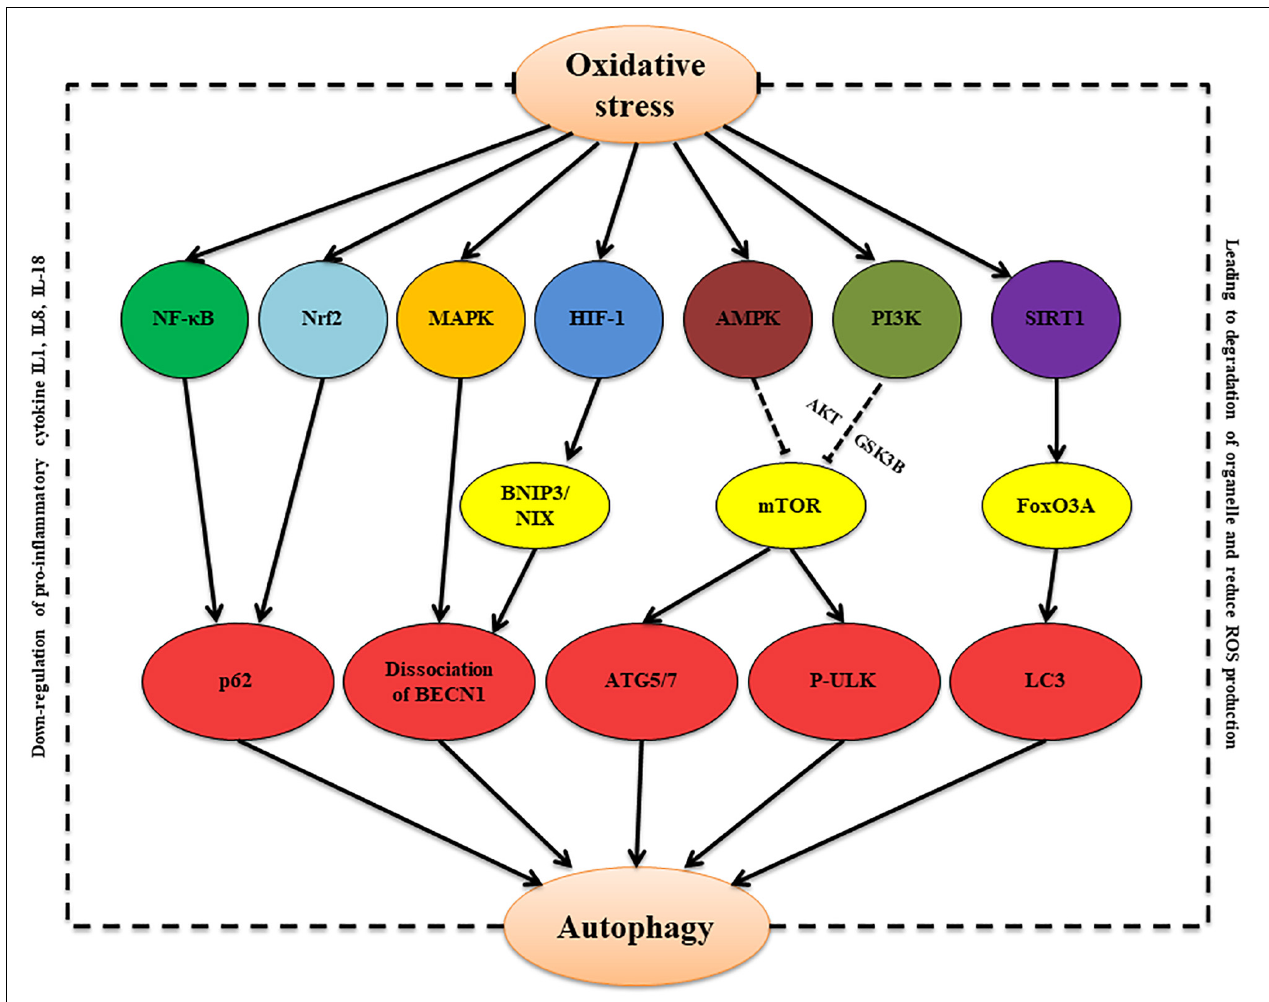
FIGURE 1 | The proposed oxidative stress/autophagy cross-talk in the bacterial infection condition. Oxidative stress induces autophagy via multiple signaling pathways, including NOX- NF- κ B-p62 signaling, Nrf2-Keap1-AREs signaling, MAPK-beclin-1 signaling, HIF-1-BNIP3/NIX-beclin-1 signaling, AMPK/PI3K-mTOR signaling, and SIRT1-FoxO3A-LC3/BNIP3 signaling. Autophagy, in turn, can attenuate oxidative through inducing degradation of damaged organelles and decreasing production of pro-inflammatory cytokines and ROS.